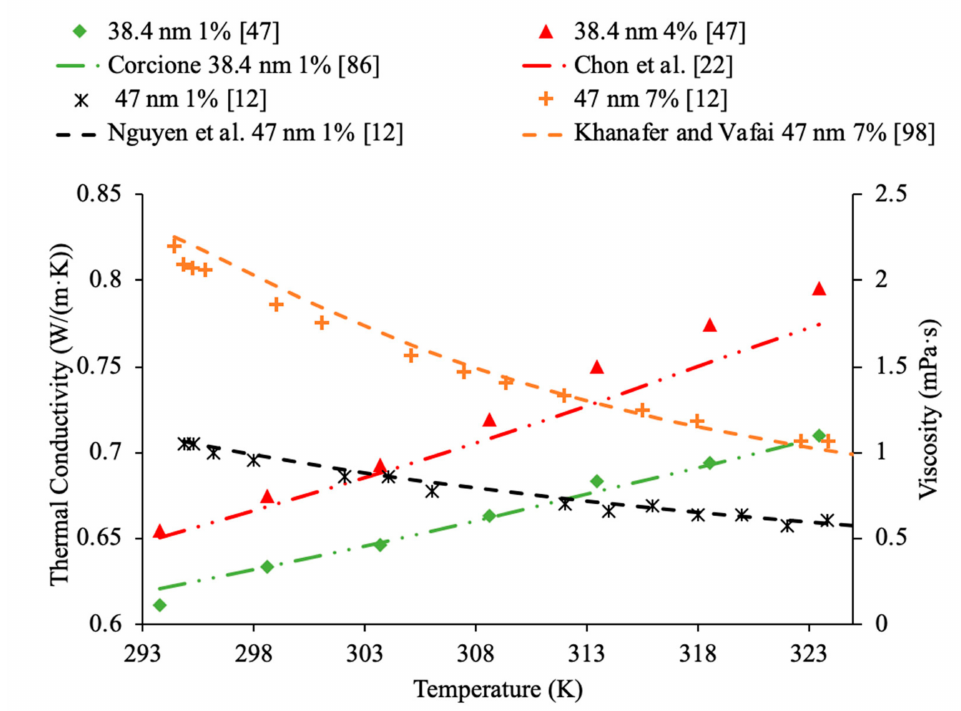
Figure 42. Thermal conductivity (increasing with temperature) and viscosity (decreasing with temperature) for 38.4 nm Al 2 O 3 –Water nanofluid at concentrations of 1% and 4% [47] and for 47 nm Al 2 O 3 –water nanofluid at concentrations of 1% and 7% [12] in comparison to different theoretical models [12,22,86,98].